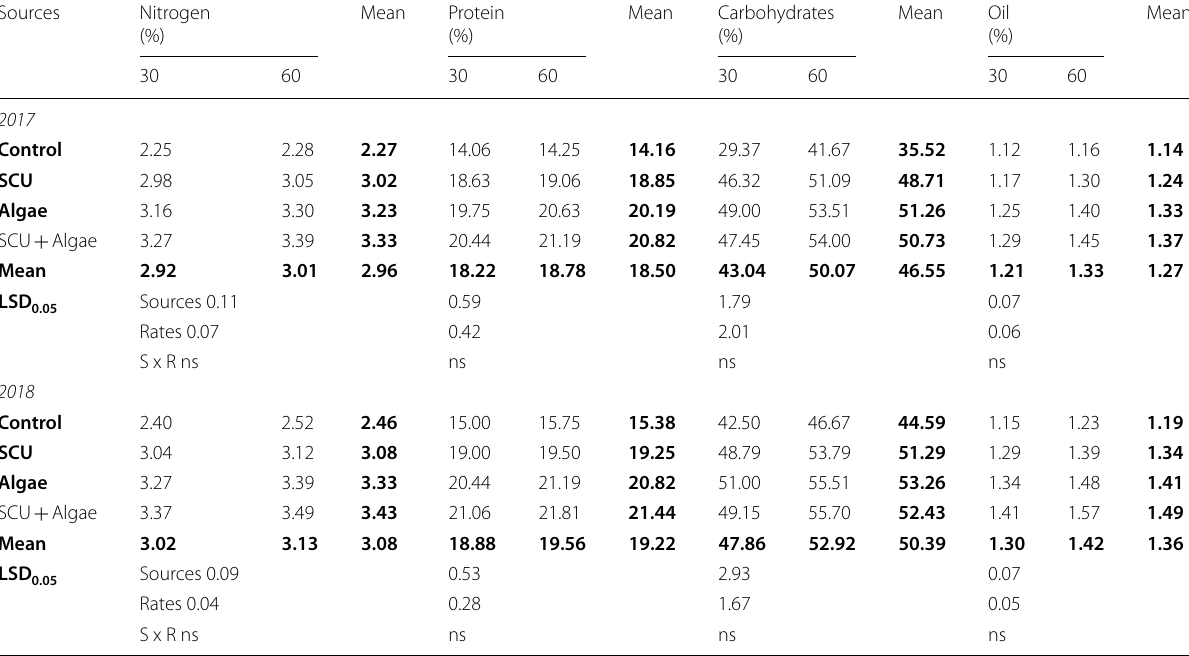
S x R Sources x Rates =